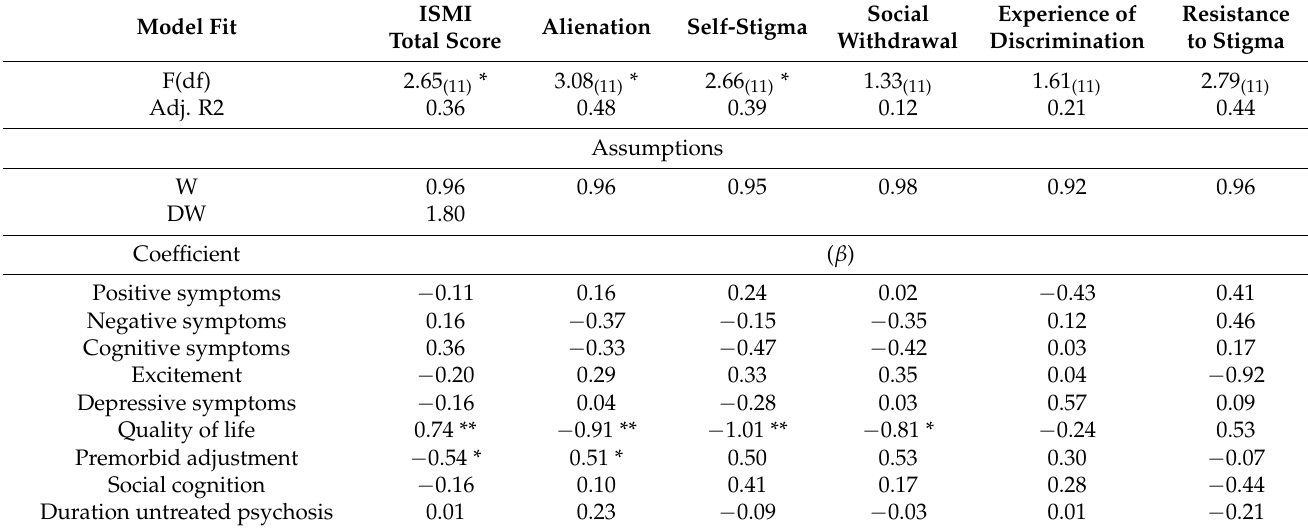
Table 3. Linear regression analysis of baseline predictors of internalized stigma at follow-up